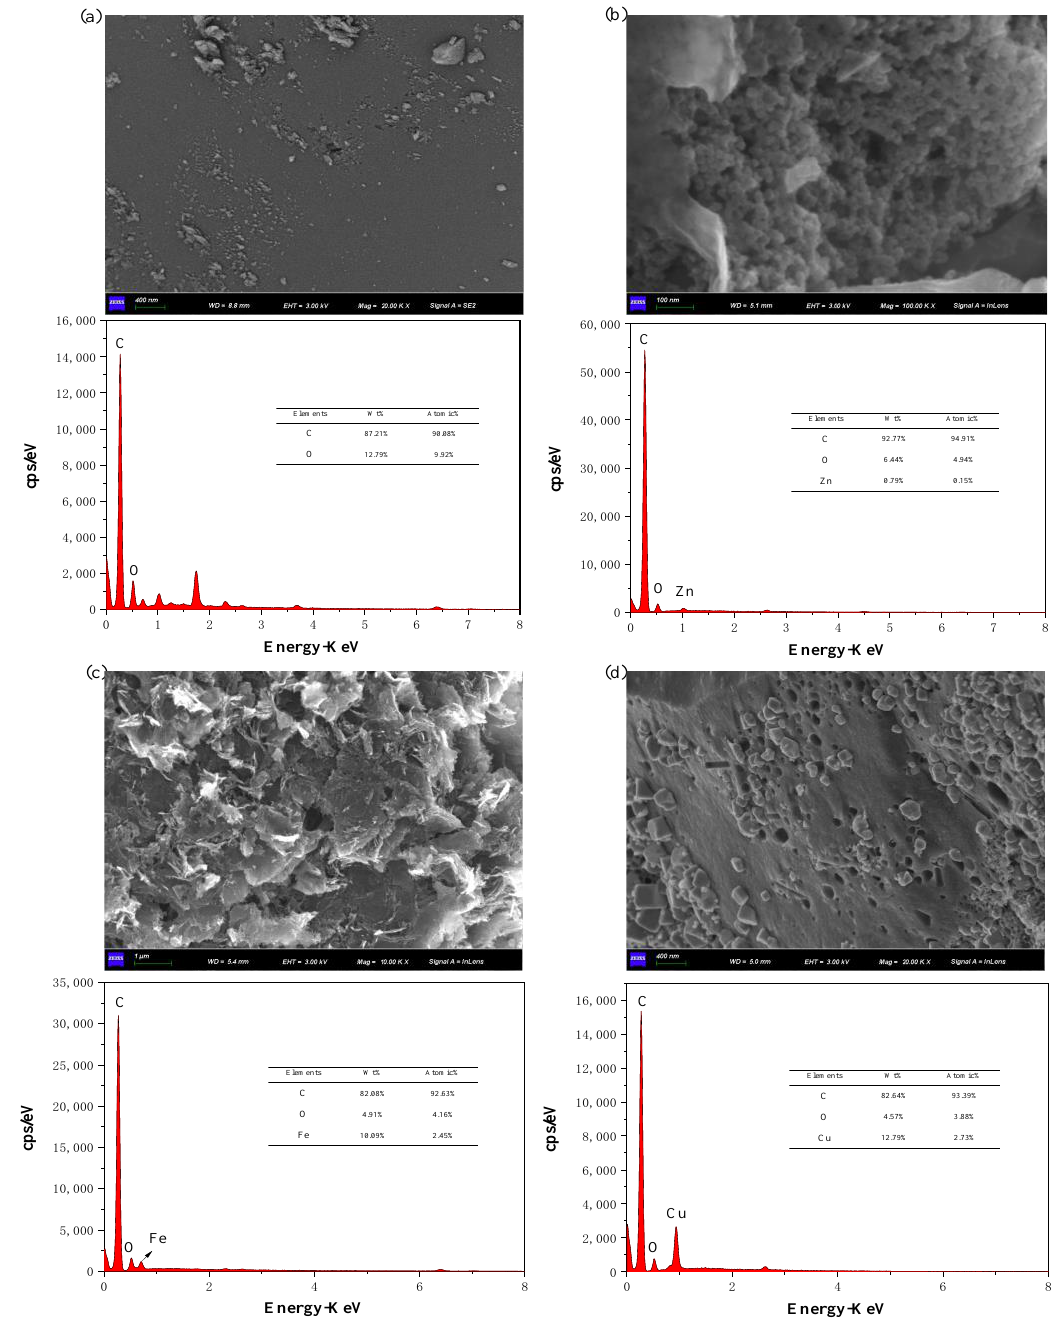
Figure 2. The SEM − EDS maps of the four samples: ( a ) AC; ( b ) Zn − AC; ( c ) Fe − AC; ( d ) Cu − AC. From Table 1, the specific surface areas of AC, Zn − AC, Fe − AC, and Cu − AC were 548.89, 847.87, 229.66, and 98.33 m 2 /g, respectively. Due to the attachment of metal oxide on the surface and pores of AC, and because high − temperature nitrogen caused the loosening of carbon structure on the surface, resulting in some micropores being blocked [31], the specific surface area of the AC decreased after its activation by FeCl 3 and Cu(NO 3 ) 2 . In addition, this causes poorly developed spatial crosslinks in the samples while the metal salt solution reaches a certain concentration, which may hinder the reac- tion between the catalyst and the carbon structure, resulting in serious external loss and the slow growth of micropores on the surfaces of the ACs [30]. The microporous propor-